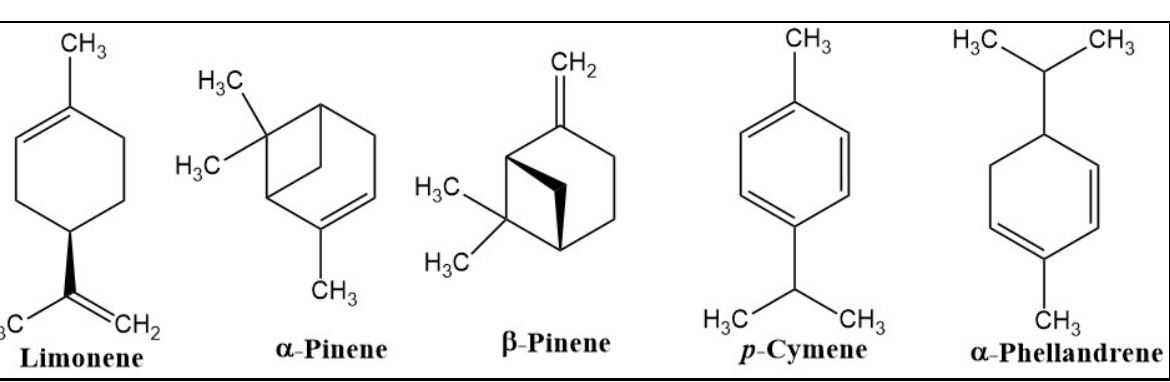
Figure 1. Chemical structure of the main identified compounds. All constituents identified in GCEO are listed in Table 1.